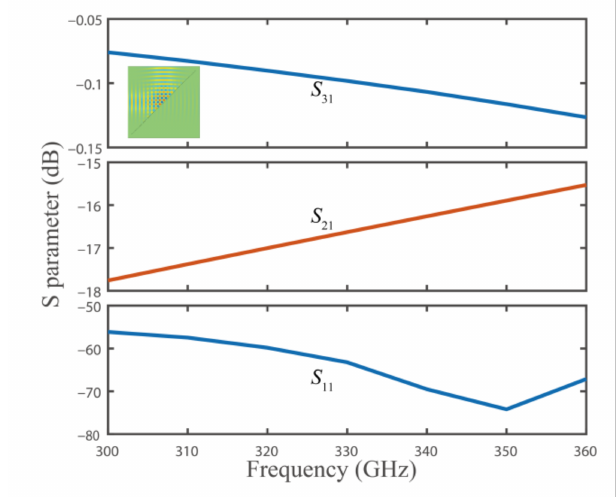
Figure 16. Simulation results of 90 ◦ bend waveguide in the frequency band of 300–360